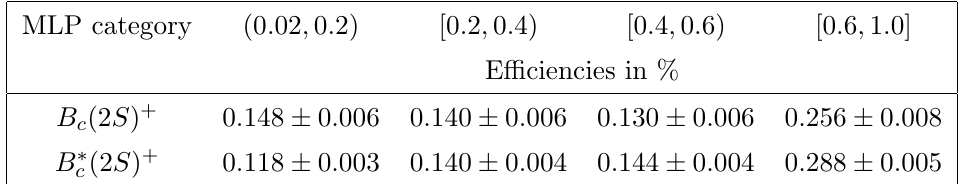
Table 1. E(cid:14)ciencies for the B ( (cid:3) ) c (2 S ) + states in the regions p T 2 [0 ; 20] GeV =c and y 2 [2 : 0 ; 4 : 5] for each MLP category. The e(cid:14)ciencies obtained before applying the MLP classi(cid:12)er are 0 : 0091 (cid:6) 0 : 0002 and 0 : 0086 (cid:6) 0 : 0001 for B c (2 S ) + and B (cid:3) (2 S ) + , respectively. The uncertainties are statistical only, c and are due to the limited size of the simulated